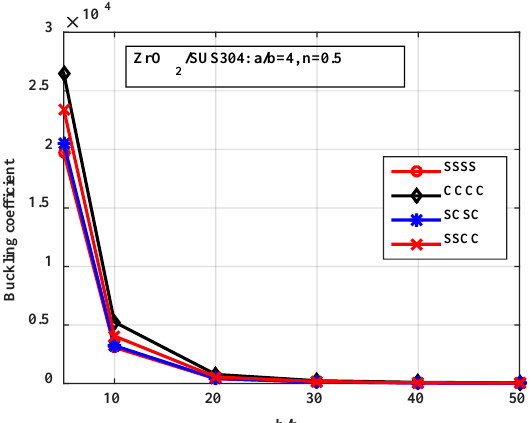
Figure 10. Variation of the buckling coefficient by the boundary condition and the thickness of the plate.